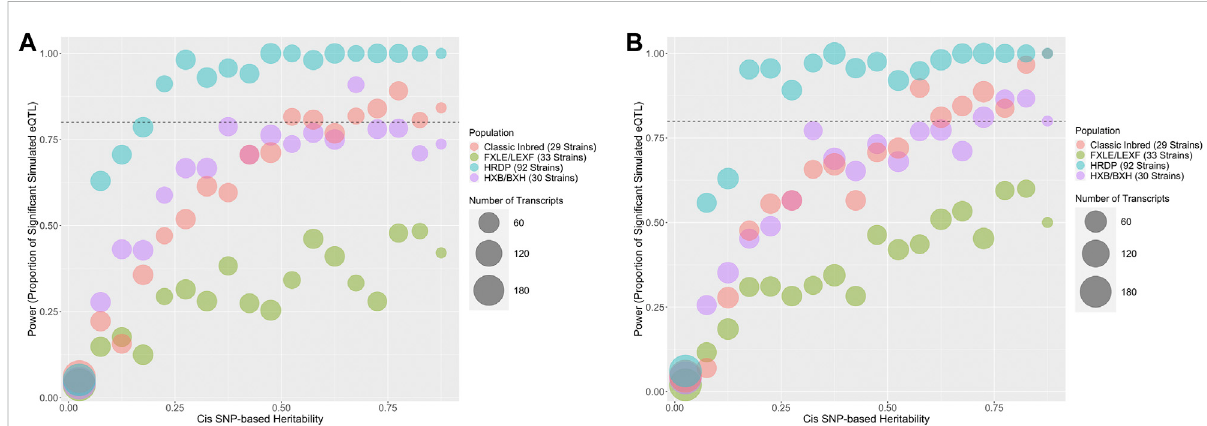
FIGURE 7 Predicted power in cis-eQTL studies based on cis-heritability of the transcript and rat population used for QTL mapping. The number of genes ineachheritabilitystrataisrepresentedbythesizeofthebubble.TheHXB/BXHRIpopulationisinpurple,theFXLE/LEXFRIpopulationisingreen,the classic inbred population is in red, and the full HRDP is in blue. Two simulation approaches were used that were based on either (A) a single cis-SNP effect or (B) multiple cis-SNP effects.